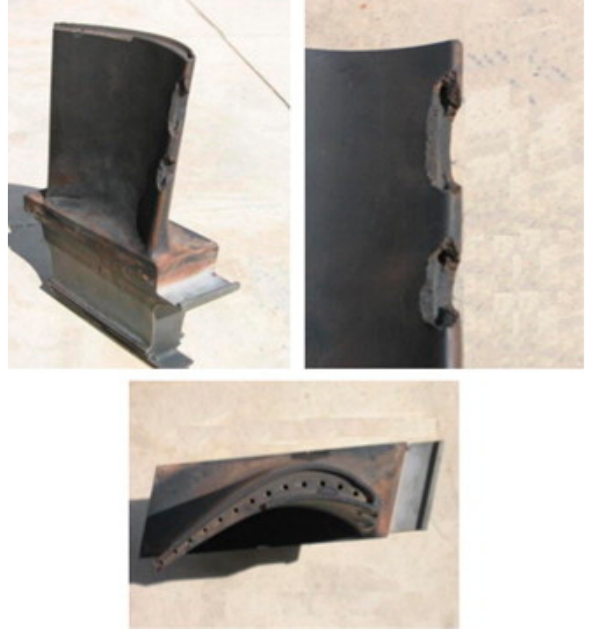
Figure 2. The general view of the first stage blade showing damaged parts on the tip of the leading edge (Reproduced from [24] with permission from Elsevier).